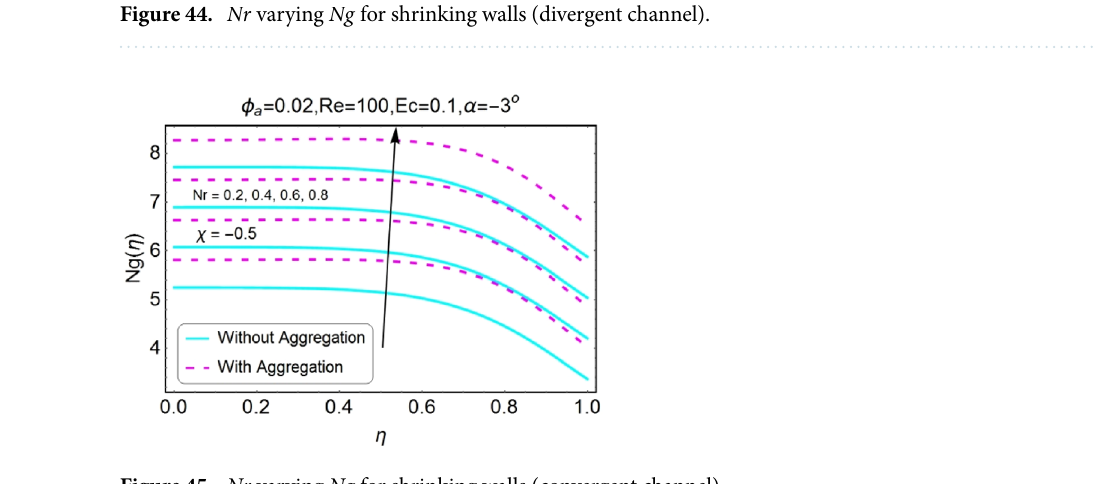
Figure 45. Nr varying Ng for shrinking walls (convergent